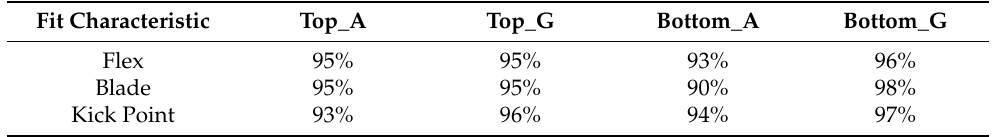
Table 6. Accuracy of various fine KNN models trained using top and bottom hand linear acceleration (_A) and angular velocity (_G) data for slap shot speed.